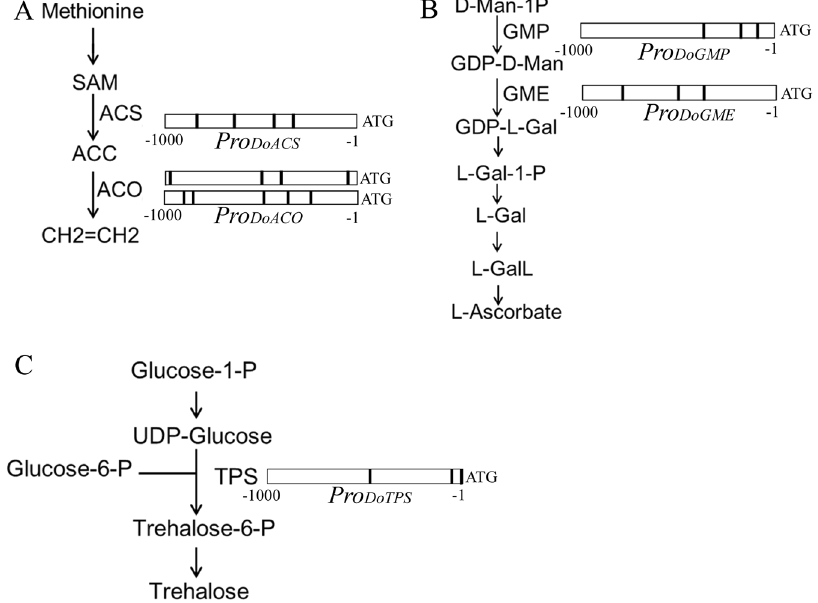
Figure 8. Analysis of the WRKY target genes in the biosynthetic pathway of ethylene, L-Ascorbate and trehalose. ( A ) One gene encoding ACC synthase (ACS) and two genes encoding ACC oxidases (ACO) contained multiple W-box elements in their 1-k upstream regulatory regions. SAM, S-adenoysl-methionine; ACC 1-aminocyclopropane-1-carboxylic acid. ( B ) Visualization of WRKY target genes in the L-Ascorbate pathway. GMP, GDP-Man pyrophosphorylase; GME, GDP-Man-3,5-epimerase. ( C ) One gene encoding trehalose-6-phosphate synthase (TPS) has three W-box elements in its 1-k upstream regulatory